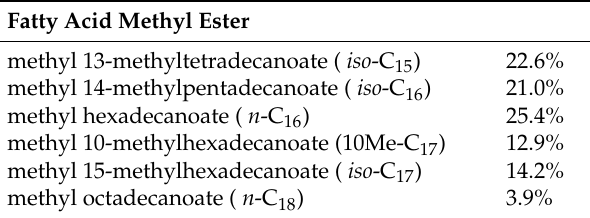
Table 2. Fatty acyl composition of zeamide ( 1 ).